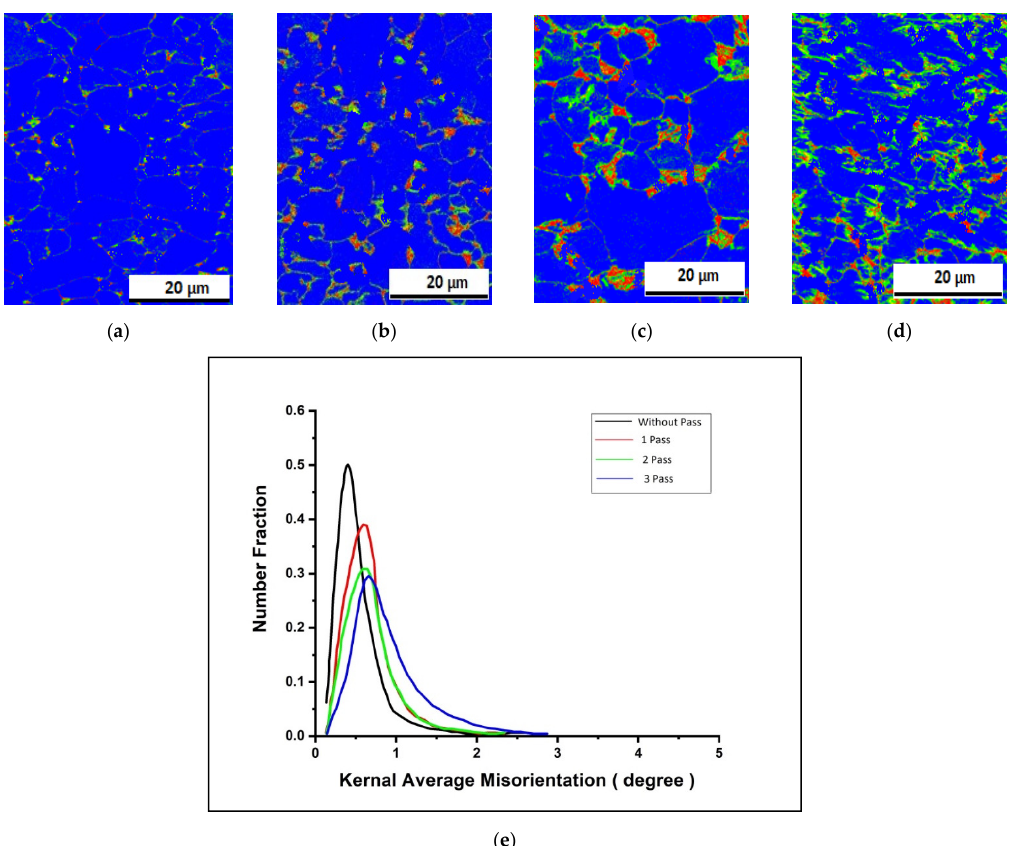
Figure 9. Kernel Average misorientation micrographs of ( a ) As received and ECAPed after ( b ) first pass, ( c ) second pass, ( d ) third pass. ( e ) Kernels average misorientation (KAM) plots at high temperature.